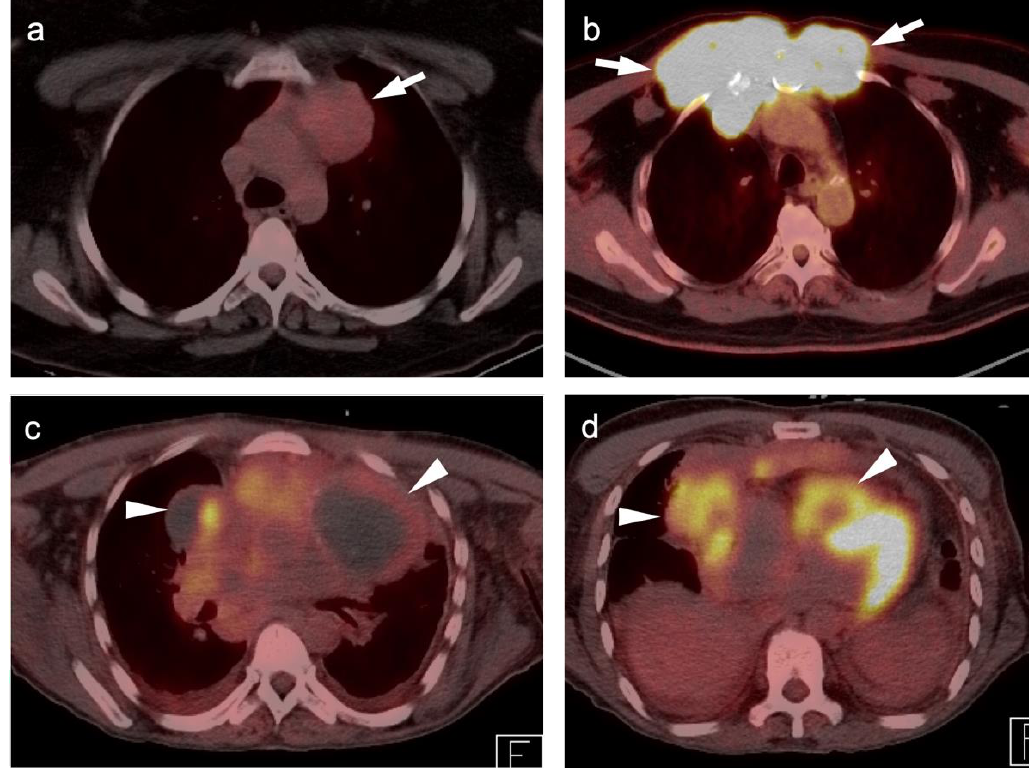
Figure 16. Three patients with primary thymic neoplasms. ( a ) Case 1: Thymoma. Smooth mild to moderate metabolically active mass (SUVmax is 5.2) in the left anterior mediastinum ( white arrow ) with many years of stability, biopsy-proven to be a thymoma; ( b ) Case 2: Thymic carcinoma. intensely hypermetabolic, invading the anterior chest wall ( white arrows ); ( c , d ) Case 3. Thymic carcinoma. ( c ) Axial FDG PET-CT image shows a complex anterior mediastinal mass with areas of cystic change ( white arrowheads ) and calcification (not well seen here); ( d ) Axial FDG PET-CT image at the level of the heart shows an intense metabolic portion of the mass ( white arrowheads ), biopsy proven to be a thymic